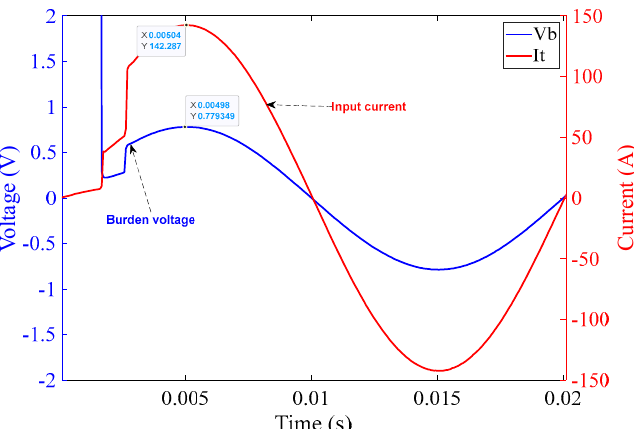
Figure 18. Burden voltage across the 10 Ω burden circuit at 100 A(rms) input current (MOSFETs switched on).